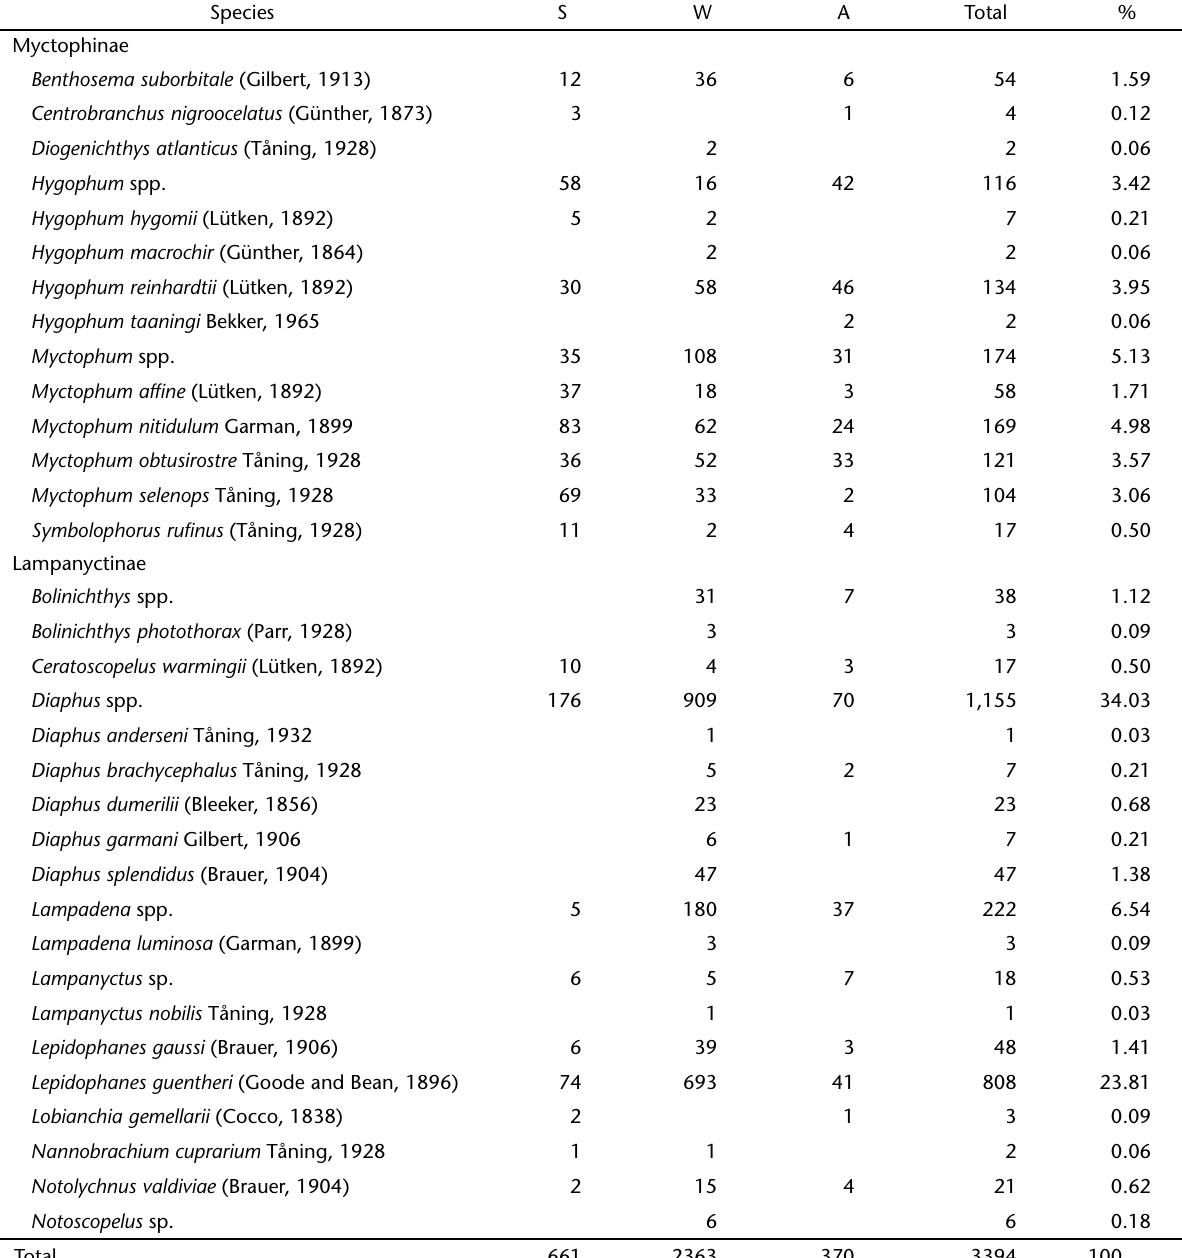
Table II. Number and percentage (%) of each Myctophinae and Lampanyctinae species collected during spring/1998 (S), winter/1999 (W) and autumn/2000 (A) cruises conducted along the Brazilian central coast.